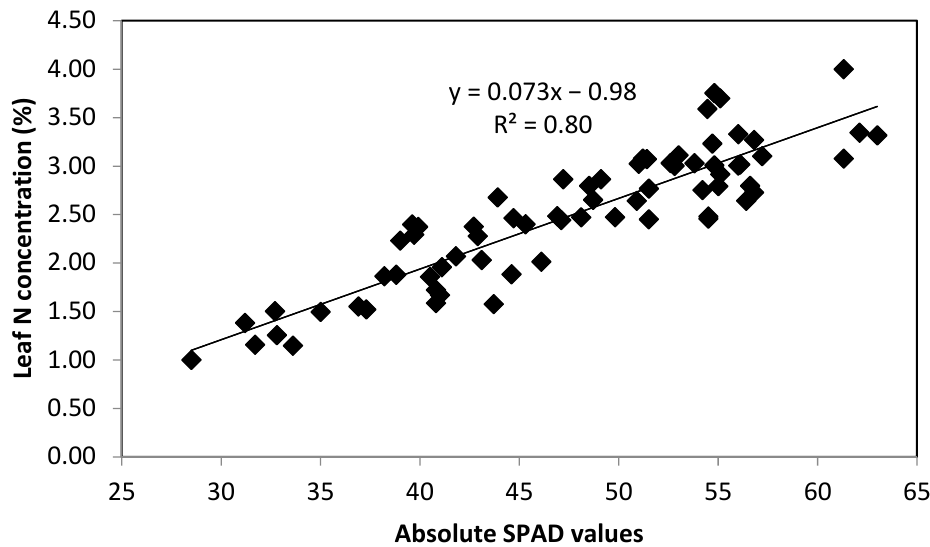
Figure 1. Leaf N concentration (%) vs. absolute SPAD values at V6, V8, V10, and V12 corn growth stages (2014 and 2015).